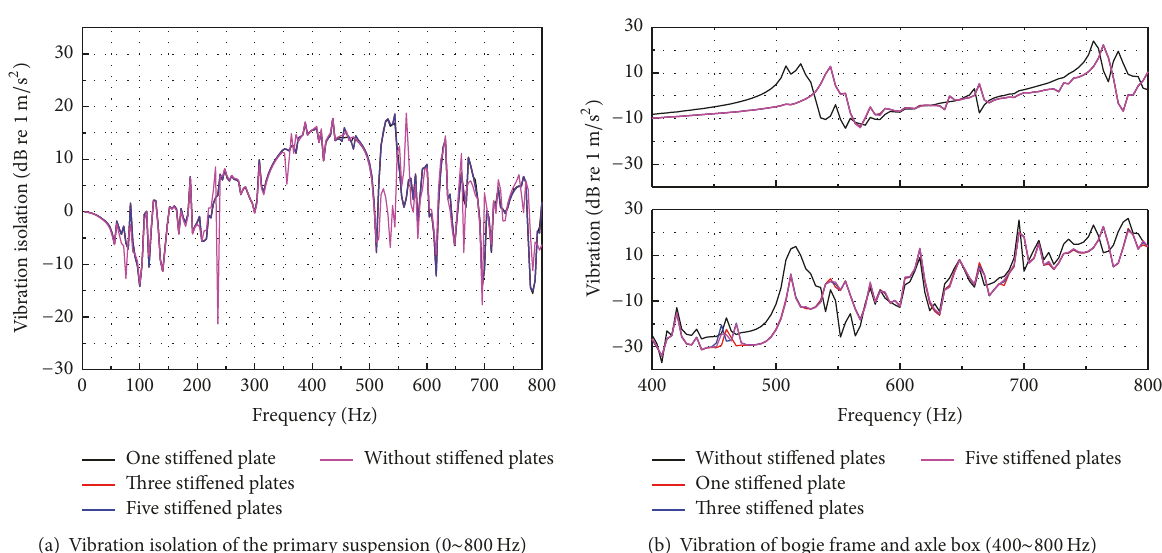
Figure 18: Different numbers of the stiffened thin